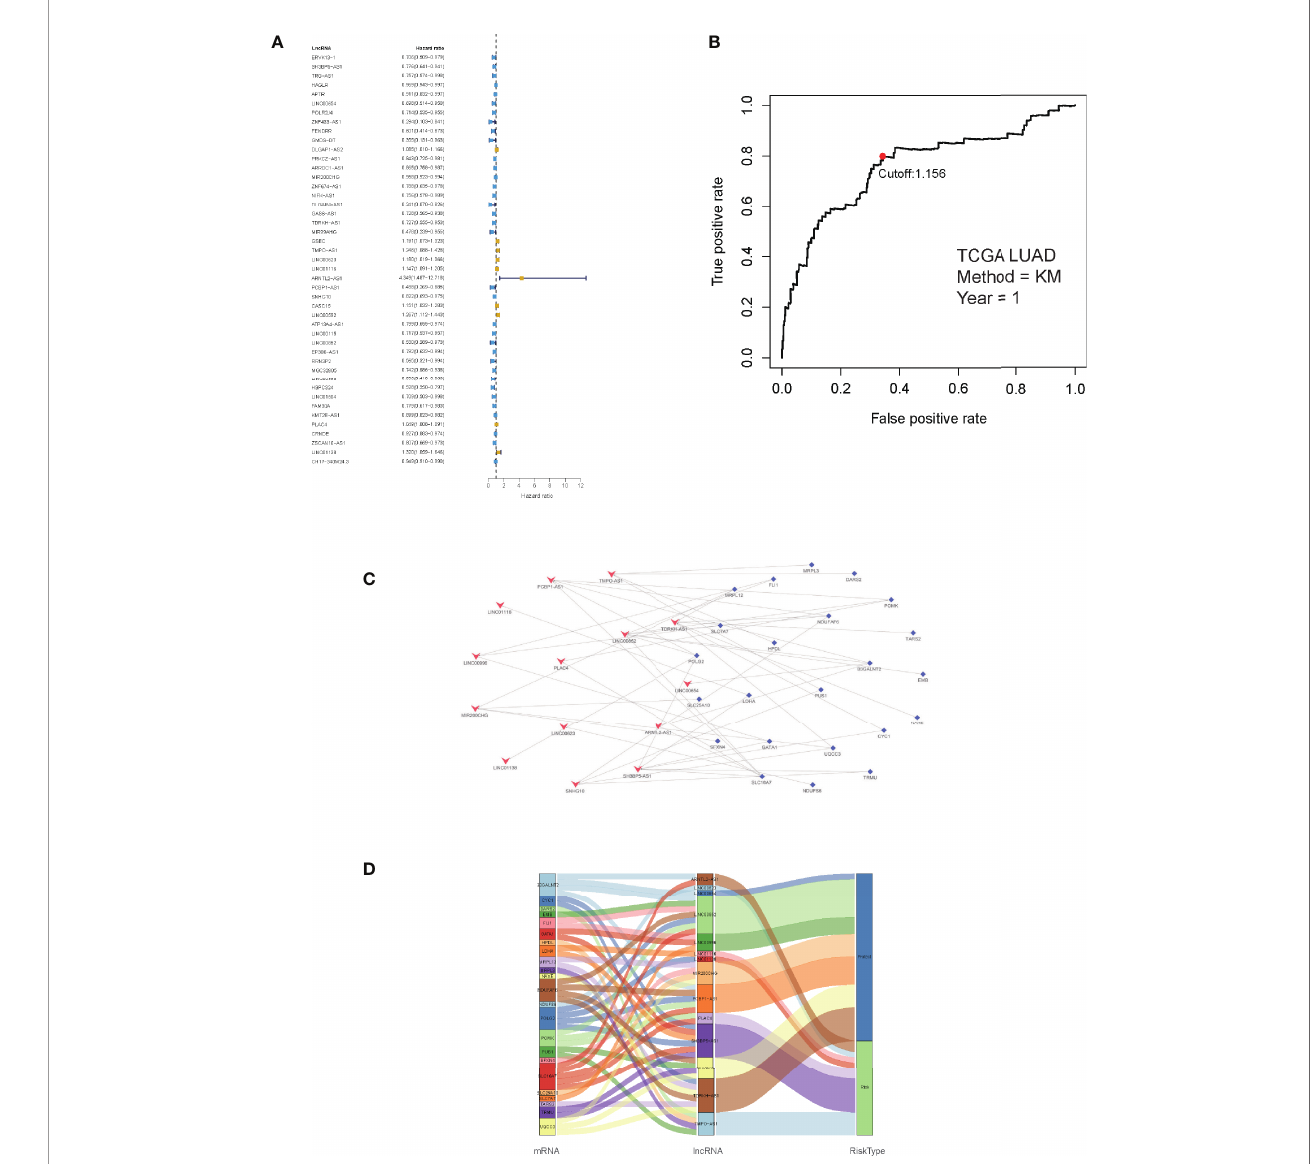
FIGURE 2 | Identi fi cation of prognostic lactate metabolism-related (LMR)-lncRNAs. (A) Forest plots of LMR-lncRNAs associated with prognosis based on univariate Cox regression fi ndings. (B) ROC curve after one year for the signature of LMR-lncRNAs in the training group. The threshold value was 1.038, which was used to divide patients into high- and low-risk groups. (C) The network of relationships between signature and relevant co-expressed LMR genes. (D) The Sankey diagram of the relationship between LMR genes, prognostic LMR-lncRNAs, and risk